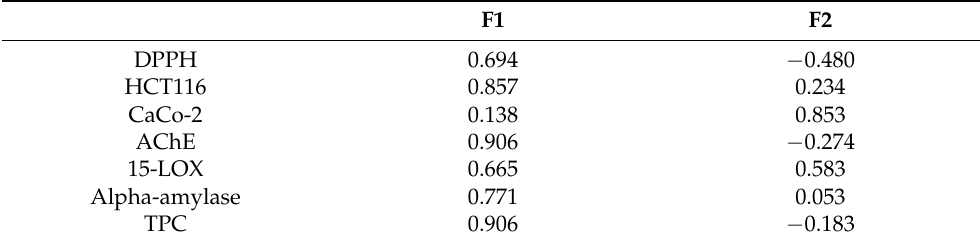
Figure 10. Principal Components analysis “loading plot” of (DPPH: Antioxidant activity) (TPC: total phenolic content) and biological activities (Alpha amylase: Antidiabetic activity); 15-LOX: Anti-inflammatory activity); (HCT-116 and Caco-2: cytotoxic activity) and (AChE: anti-Alzheimer activity) of V. vinifera stem extracts. Table 7. Correlations between variables and